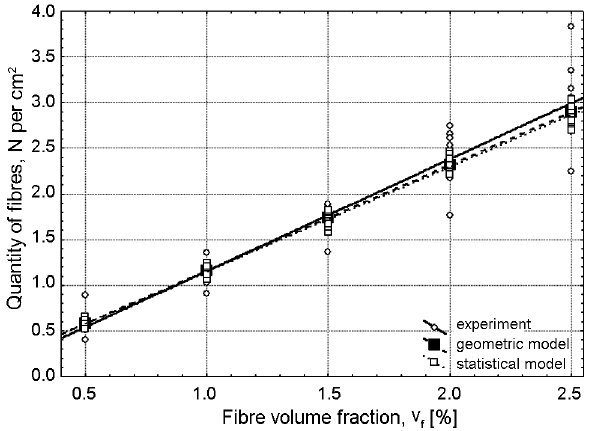
Fig. 7. Relationship between the quantity of steel fibres N per 2 1 cm of the element cross-section and their percentage in com- posite volume v f